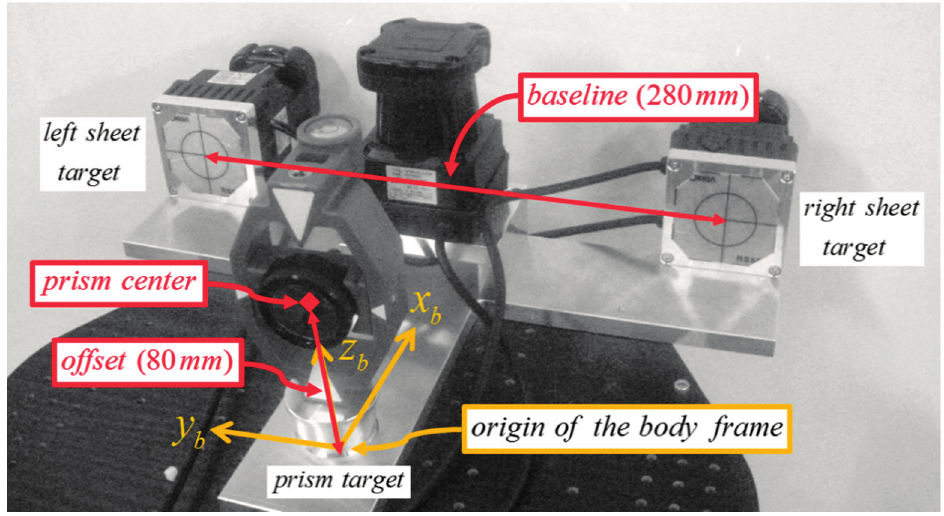
Figure 6. Prism and sheet targets for total station